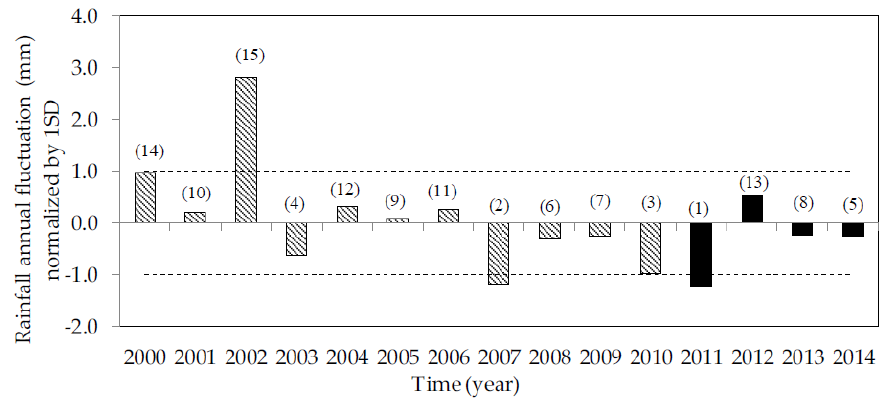
Figure 3. Normalized annual precipitation for the period 2000–2014. Dark bars indicate the study period. The years are ranked from the driest to the rainiest in parentheses. Dashed lines represent ±1SD.